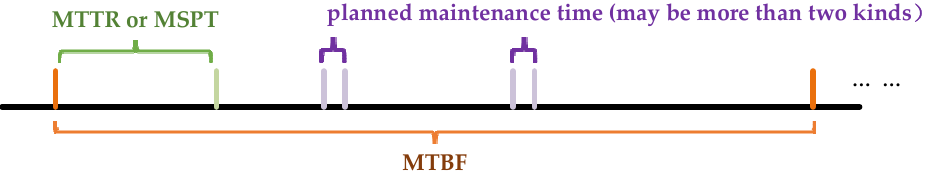
Figure 1. Physical meaning diagram of availability. MTIR—mean time to repair, MSPT—mean shop processing time, MTBF—mean time between failures.